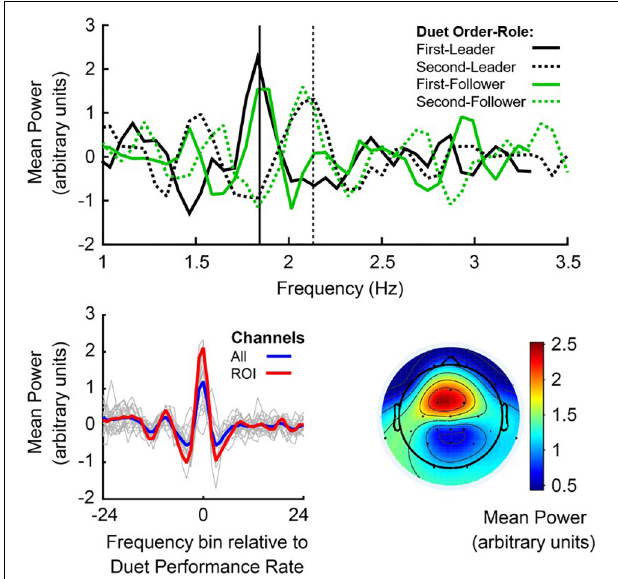
FIGURE 4 | Power Spectral Density, centered at the Duet performance rate. Top panel: Noise-normalized power spectra from a sample pair of duet pianists for First-Leader (solid lines) and Second-Leader conditions (dashed lines), where the Leader’s mean Power in each condition is shown in black and the Follower’s mean Power in each condition is shown in green. Frequency (Hz) is shown on the x-axis and mean noise-normalized power is shown on the y-axis. Vertical lines indicate the mean Duet performance rate (averaged across partners) in Hertz (# tones per second) in First-Leader (solid vertical) and Second-Leader (dashed vertical) conditions. Bottom panel (left): Mean power spectra centered at the frequency of each Duet performance, shown for each pair in thin gray lines and grand average across pairs in blue; a priori defined auditory-motor ROI (FC1, FC2, Fz, and Cz) in red. The zero-frequency bin on the x-axis represents each pair’s Duet performance rate (center of each spectrum). Bottom panel (right): Grand average topography of spectral power at the mean Duet performance rate (zero-frequency bin of left panel), averaged within pair across conditions and then across pairs.